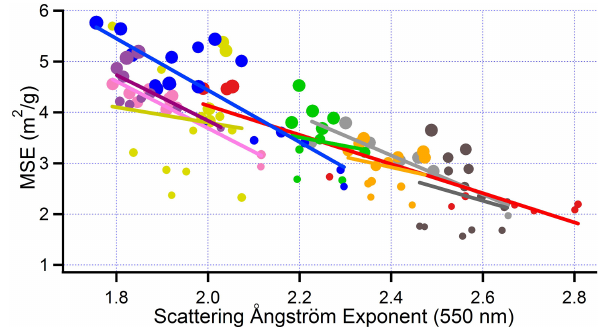
Figure 18. Mass scattering efficiency at 550nm as a function of scattering Ångström exponent at 550nm. Same format as Fig.